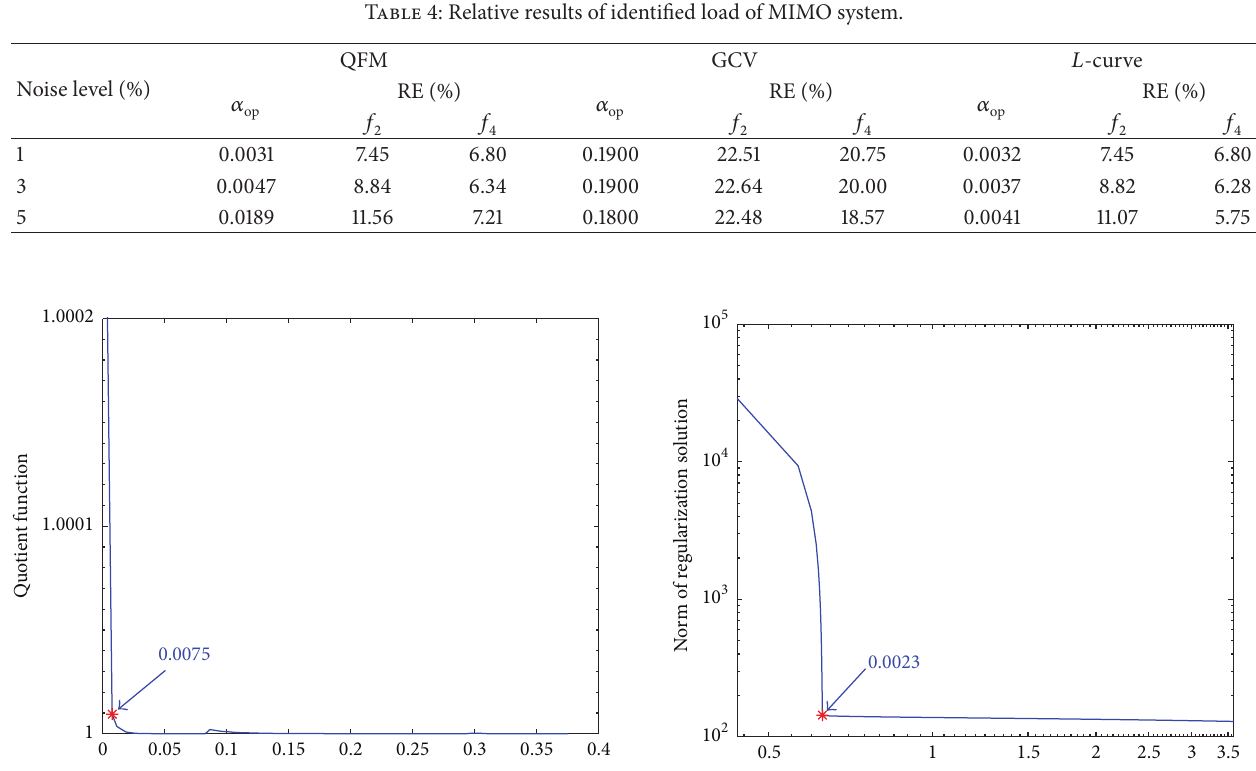
residual0.5 Norm of Figure 8: L -curve for impact load identification of SISO